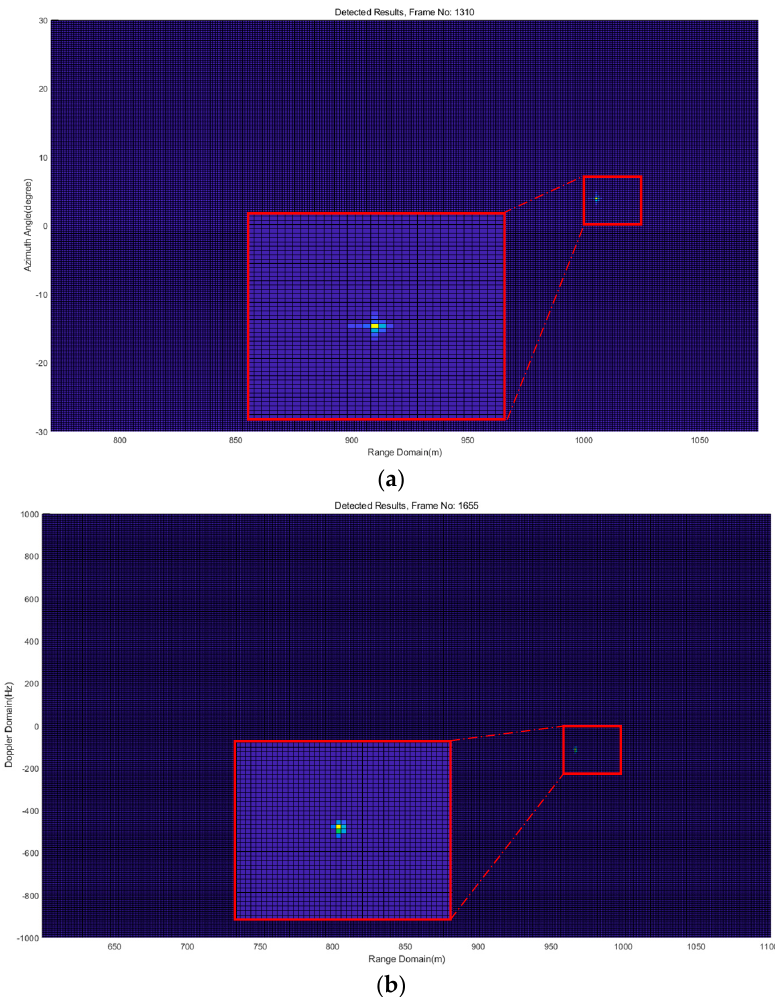
Figure 18. Illustration of one frame of detection results of Experiment 2, ( a ) range-Doppler map; ( b ) range-angle map.